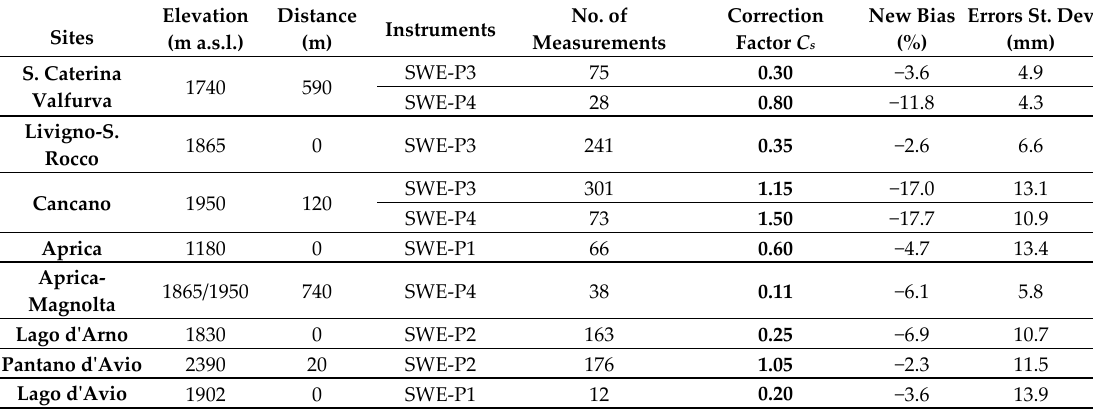
Table 3. Estimate of the correction factor C s for each monitoring site and statistics of the resulting errors by considering the freshly-fallen snow water equivalent as the ‘true’ reference measurement.